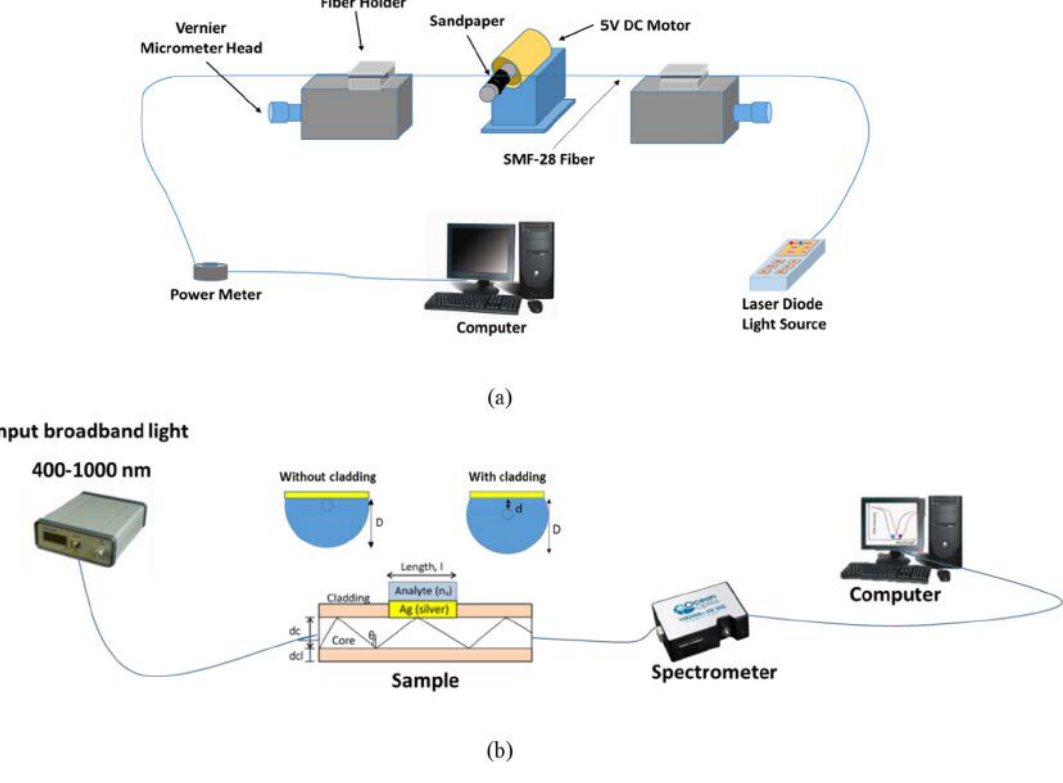
Figure 7. ( a ) Schematic demonstration of fabrication process of side-polished optical fiber and ( b